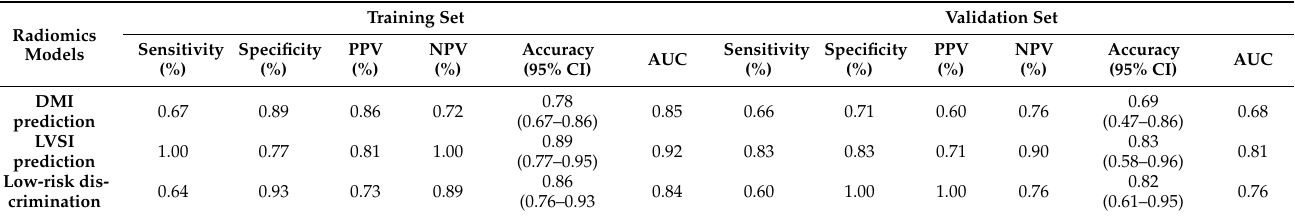
Table 3. Performance and Accuracy metrics of Radiomics Models in Training and Validation sets for predicting DMI and LVSI and discriminating low-risk group versus the other risk groups.